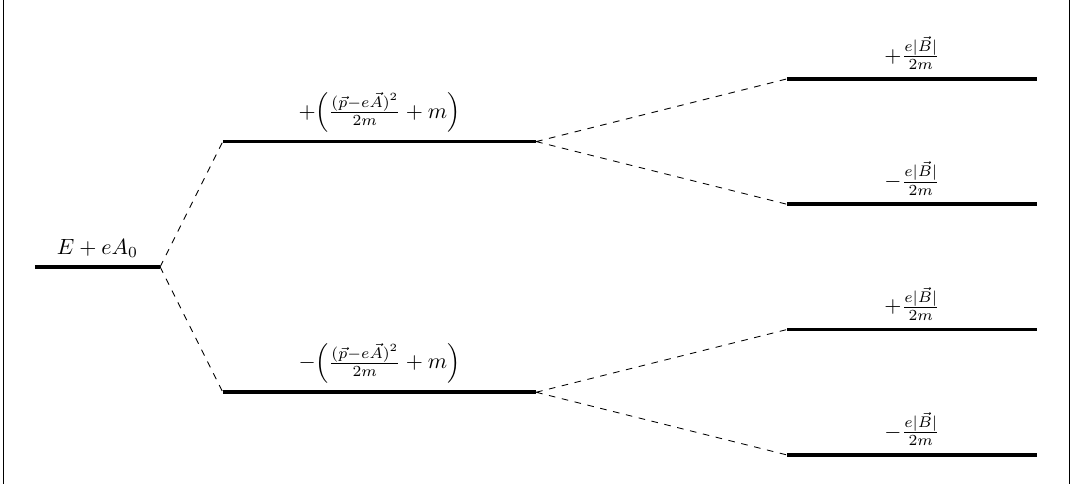
Figure 1. Zeeman-splitting in the electromagnetic